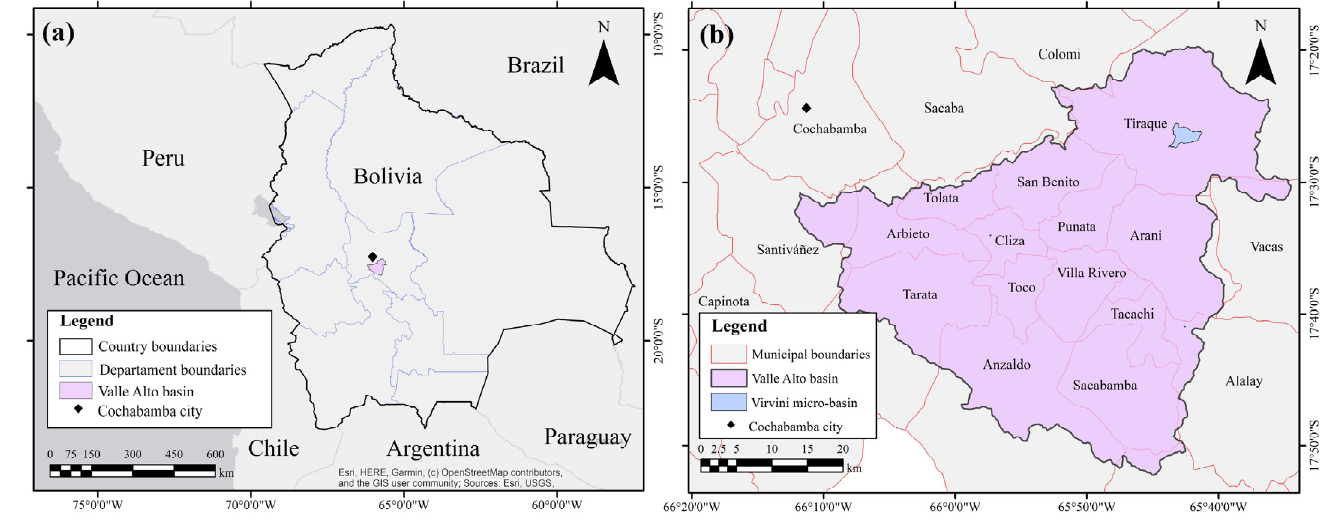
Figure 1. Location of the study area. ( a ) The Valle Alto basin, located in the Cochabamba Department in the central part of Bolivia; ( b ) The Virvini micro-basin, situated northeast of the Valle Alto basin within Tiraque Municipality.